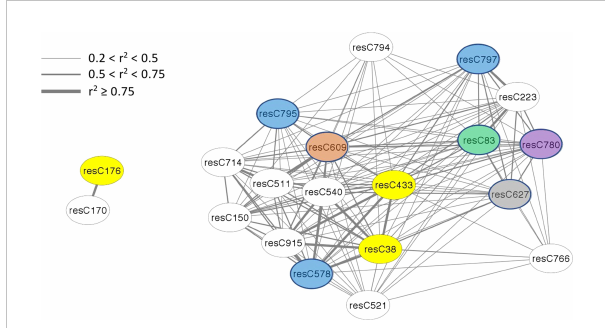
FIGURE 4 Alpha-chaconine (resC176, grey module), beta-chaconine (resC433, bisque4 module), and their nearest neighbors within the network. Twenty features of the tuber composition network are shown here, identi fi ed by feature name within the oval labels. Edges express the pairwise correlation between nodes with line width depicting r 2 values according to the inset scale. Features that could be identi fi ed are color-coded, with glycoalkaloids in yellow, peptides in blue, a polyphenol in brown, a napthofuran in gray, a fatty acid in green, and choline in